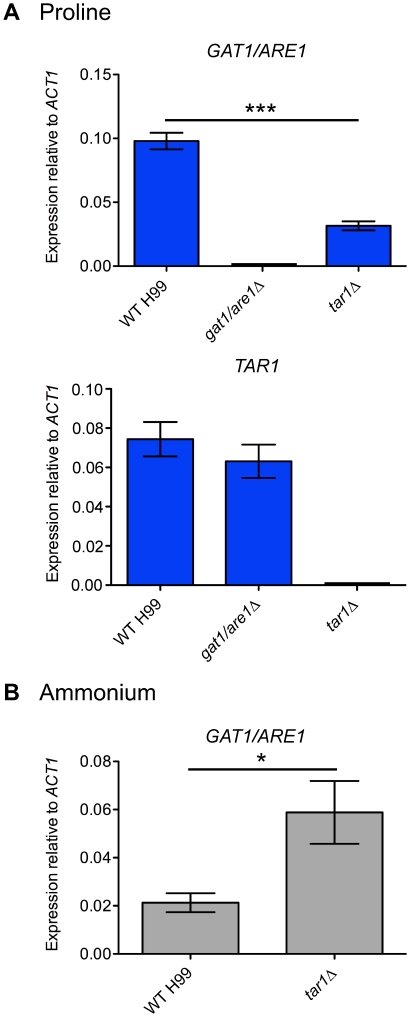
Tar1 plays both positive and negative roles in regulating GAT1/ARE1 transcription according to the nitrogen source available.(A) cDNA from wild-type H99, gat1/are1Δ and tar1Δ mutant strains grown in YNB supplemented with 10 mM proline were amplified via qRT-PCR using primers against GAT1/ARE1, TAR1 and the control gene ACT1. The expression of GAT1/ARE1 was significantly lower in the tar1Δ mutant compared to wild-type (*** denotes P<0.001). Error bars represent standard errors across three biological replicates. (B) cDNA from wild-type H99 and tar1Δ mutant strains grown in YNB supplemented with 10 mM ammonium were amplified via qRT-PCR using primers against GAT1/ARE1 and ACT1. The expression of GAT1/ARE1 was significantly higher in the tar1Δ mutant compared to wild-type (* denotes P<0.05). Error bars represent standard errors across three biological replicates.